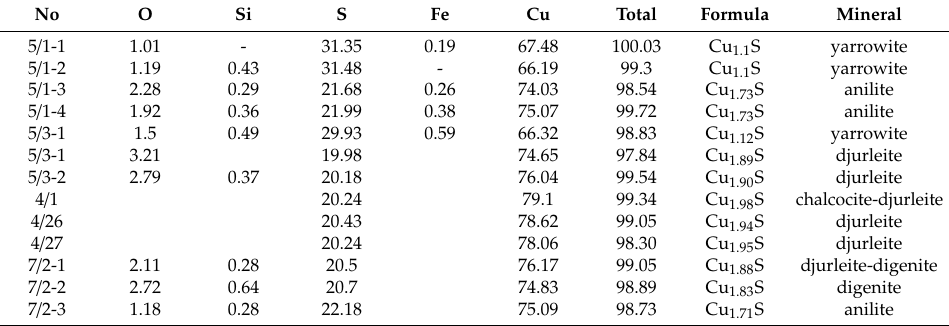
Table 1. Representative с omposition of Cu-S minerals (EPMA data in wt.% and formula) in agates from the Avacha Bay (Eastern Kamchatka,